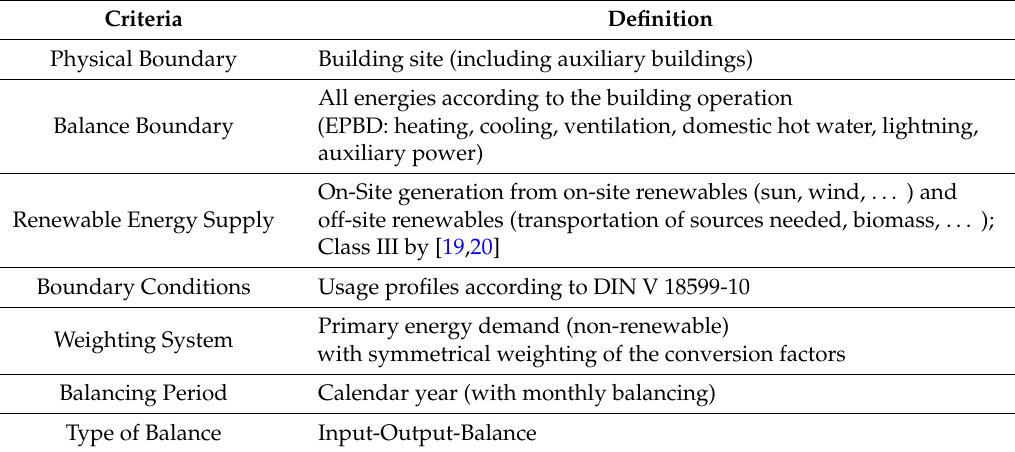
Table 2. Overview of the Nearly Zero Energy Standard definition